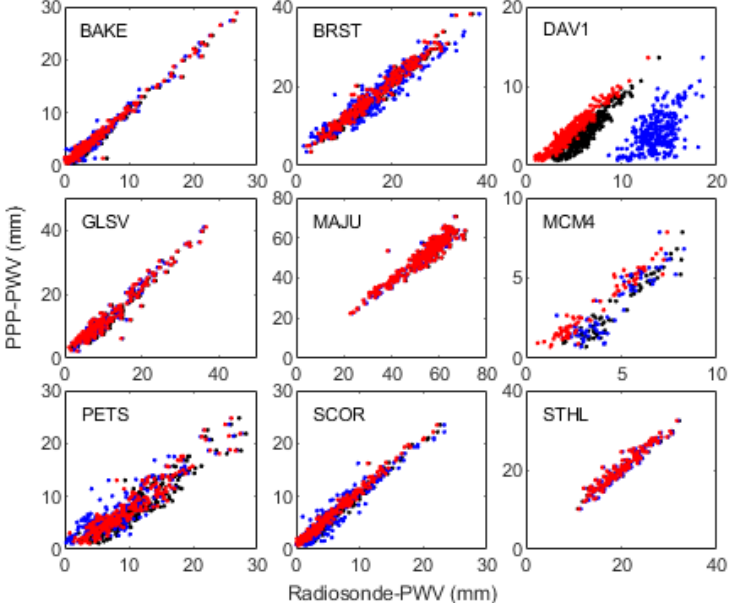
Figure 8. Correlation between the PWV converted from PPP-ZWD of 154 days in 2020 at nine IGS stations resulting from three VMF products (the results of products 1 to 3 are in black, blue, and red, respectively) and the reference PWV from radiosonde data.